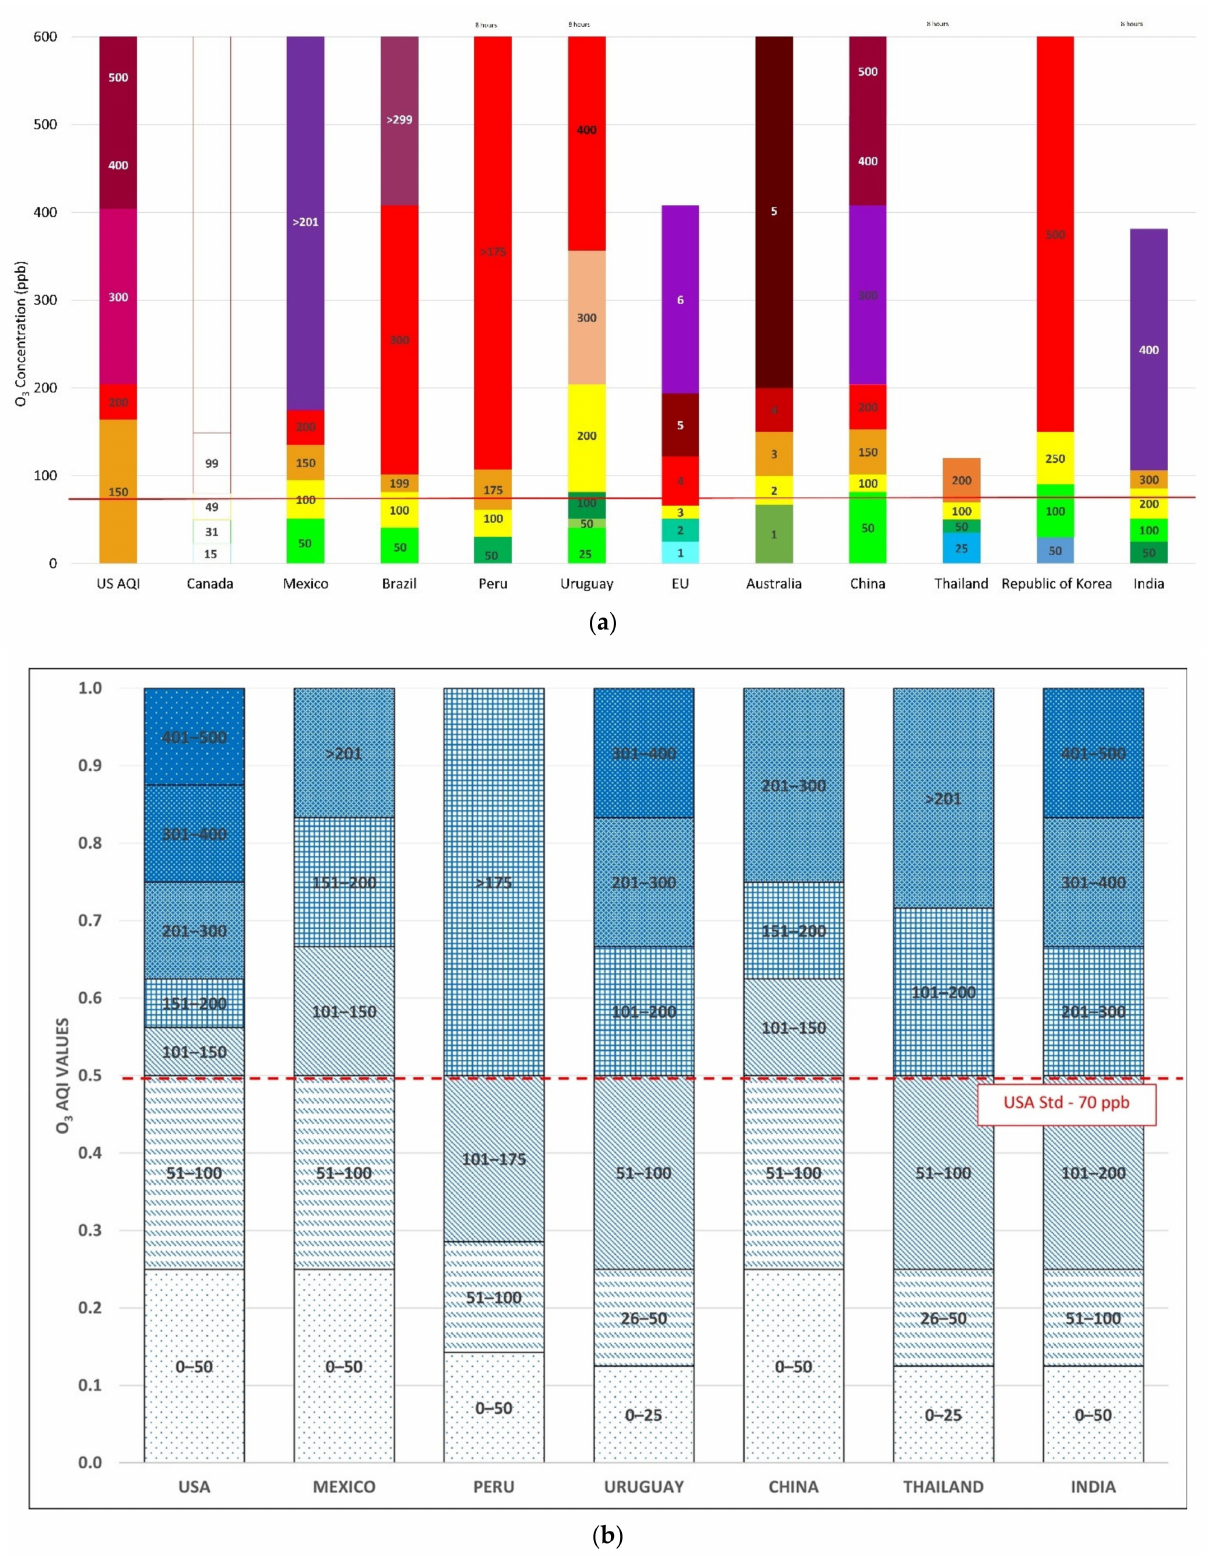
Figure 5. ( a ) O 3 concentration corresponding to AQI classes in different countries (above the bars, the averaging periods when different from 1 h). The red line represents the USA standard value. ( b ) Normalized O 3 AQI values (based on 8-h averaged